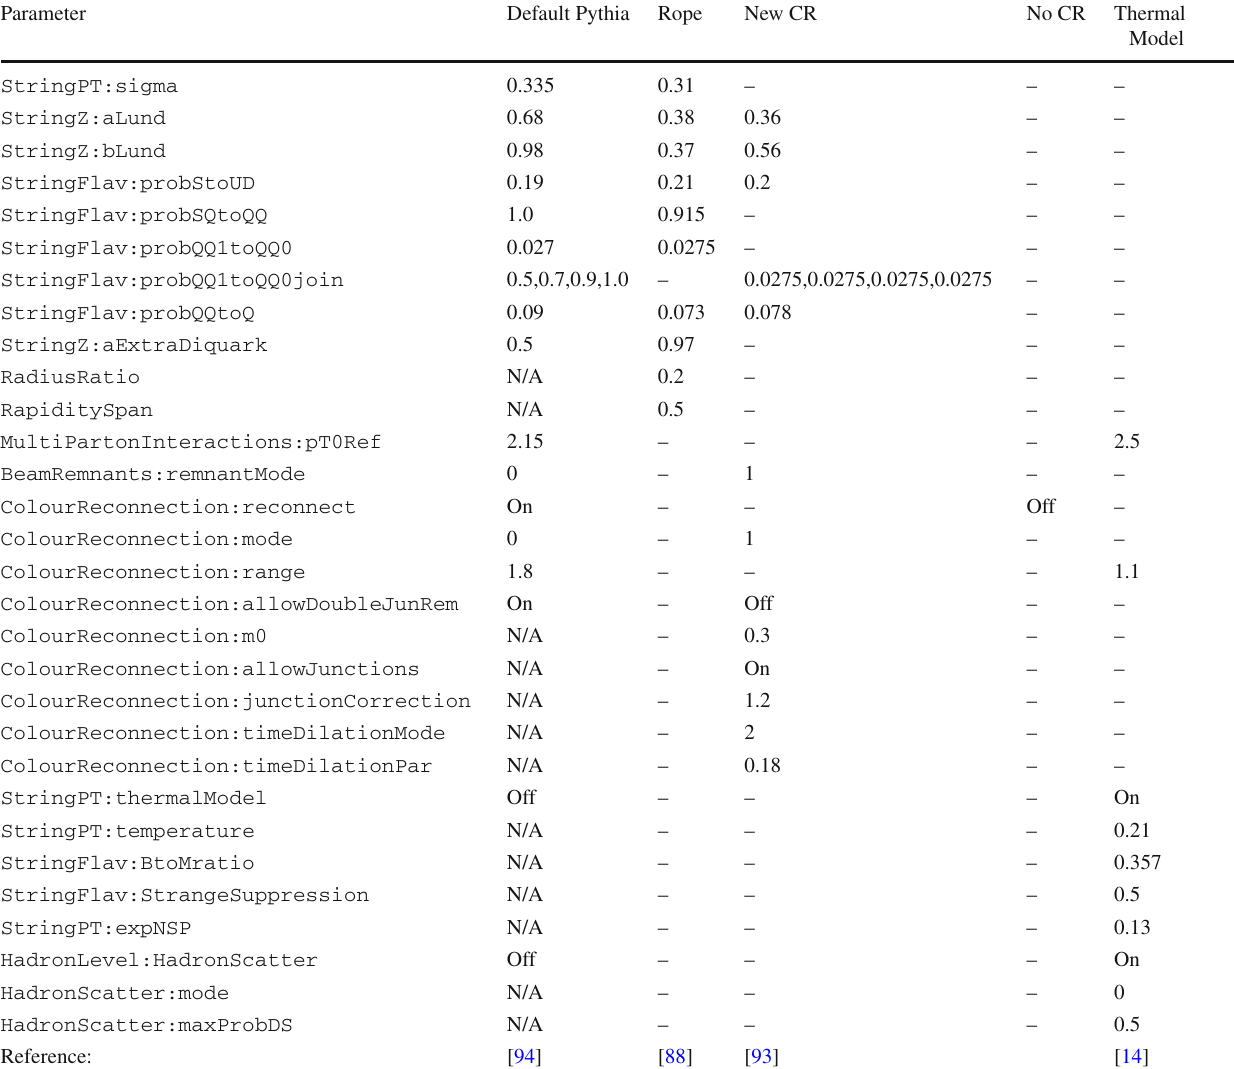
Table 1 The parameters used for the various models described in this paper. A ‘–’ indicates that the same value as the default model is